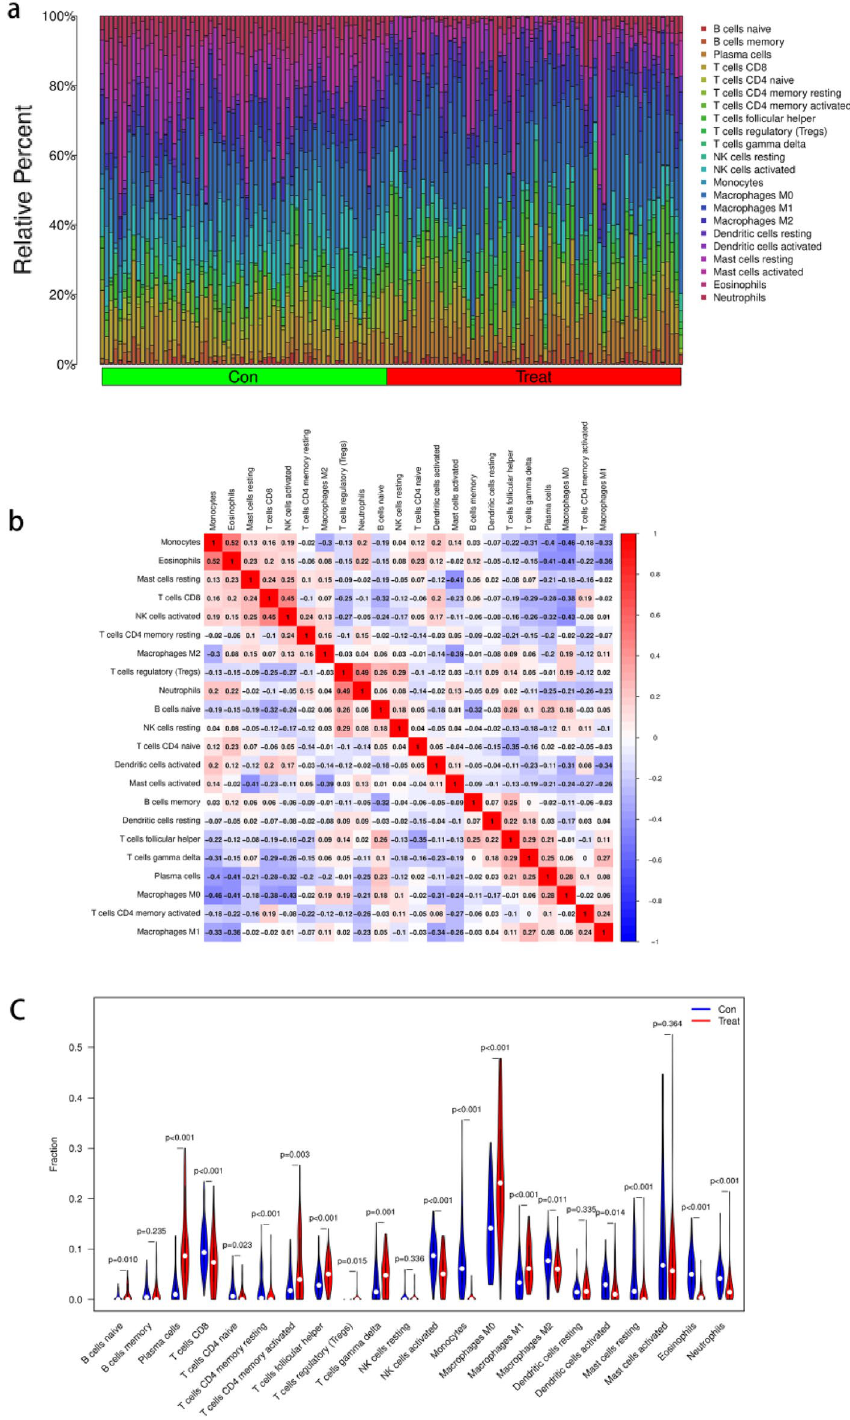
Figure 8. Correlation analysis among immune cells and Differential analysis of immune cells. ( a ) The 22 immune cell populations in normal lung tissue and NSCLC. ‘con’ represents normal lung tissue, ‘treat’ represents NSCLC. The vertical coordinate represents the amount of immune cells. ( b ) Correlation heatmap Indicates the correlation analysis of immune cells. The redder of the point, the stronger the positive correlation, the reddest point represents the two immune cells with the most significant positive correlation. The bluer the colour of the point, the stronger the negative correlation, the two immune cells with the most significant negative correlation correspond to the bluest points. ( c ) The vioplot showed the difference in 22 immune cells between normal lung tissue and NSCLC. ‘con’ represents normal lung tissue, ‘treat’ represents NSCLC. P < 0.05 means difference is statistically